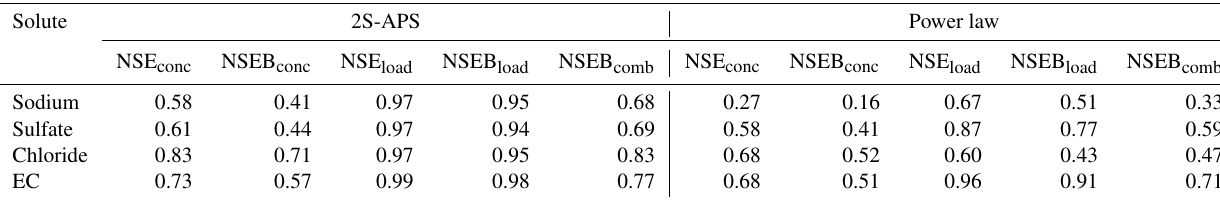
Table 5. NSE criteria computed for the three ions and EC. Solute